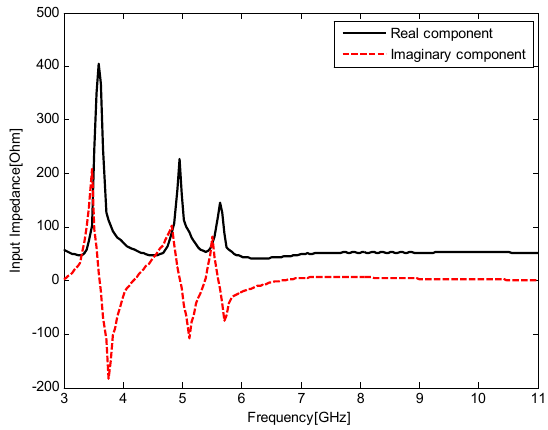
Figure 4. Input impedance Z of the antenna versus frequency.